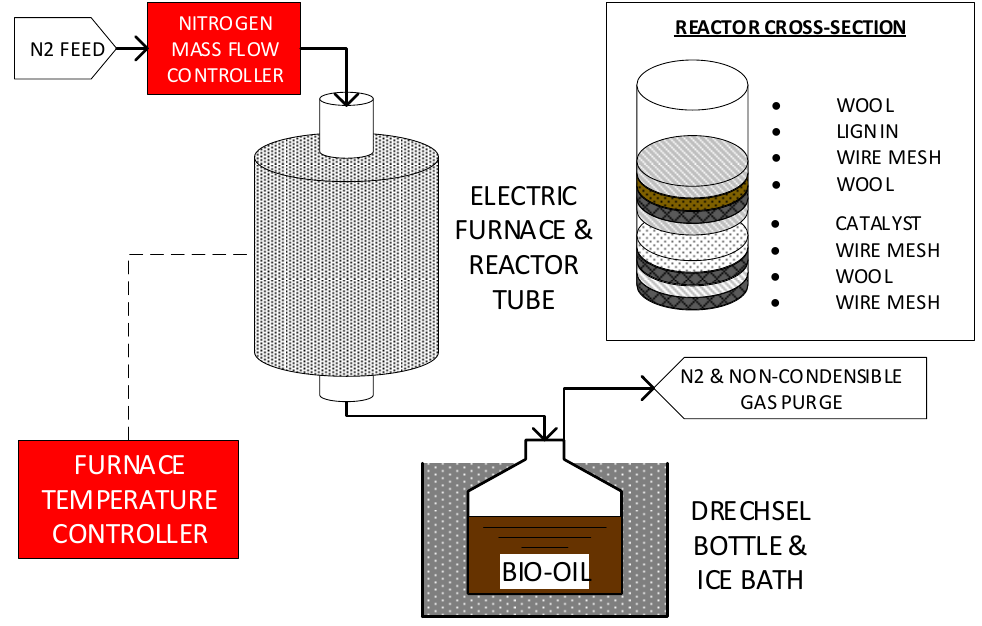
Figure 6. Experimental Apparatus.